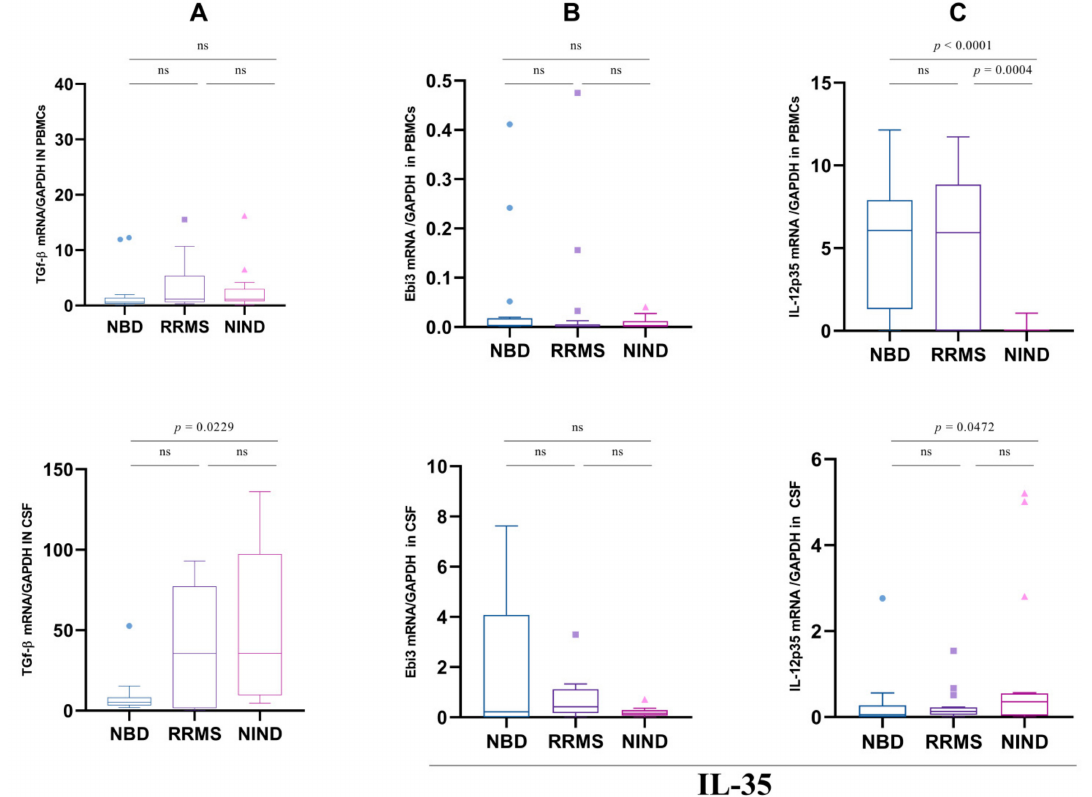
Figure 2. Boxplots representation of CSF and PBMCs regulatory cytokines expression in patients and NIND. ( A ) Representative boxplots of TGF- β expression in the PBMCs and CSF cells of NBD ( n =